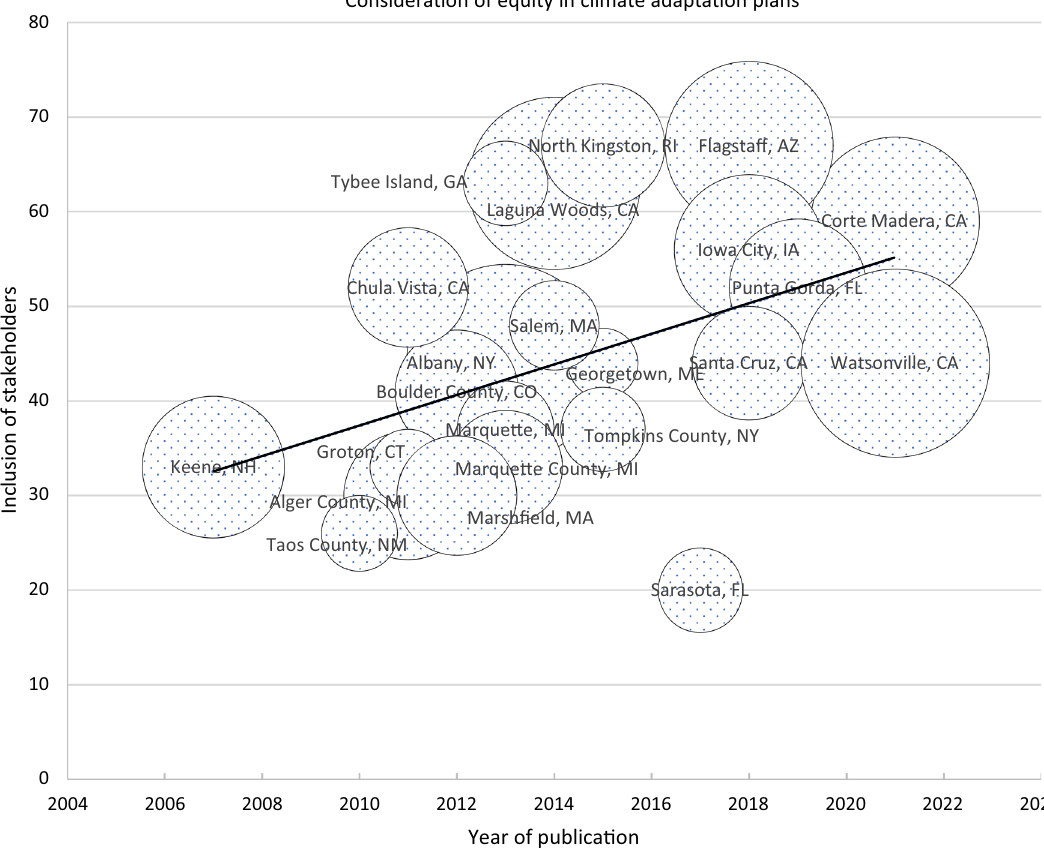
Fig. 5 Consideration of equity in climate adaptation plans and inclusion of stakeholders changing with time (bubble size represents